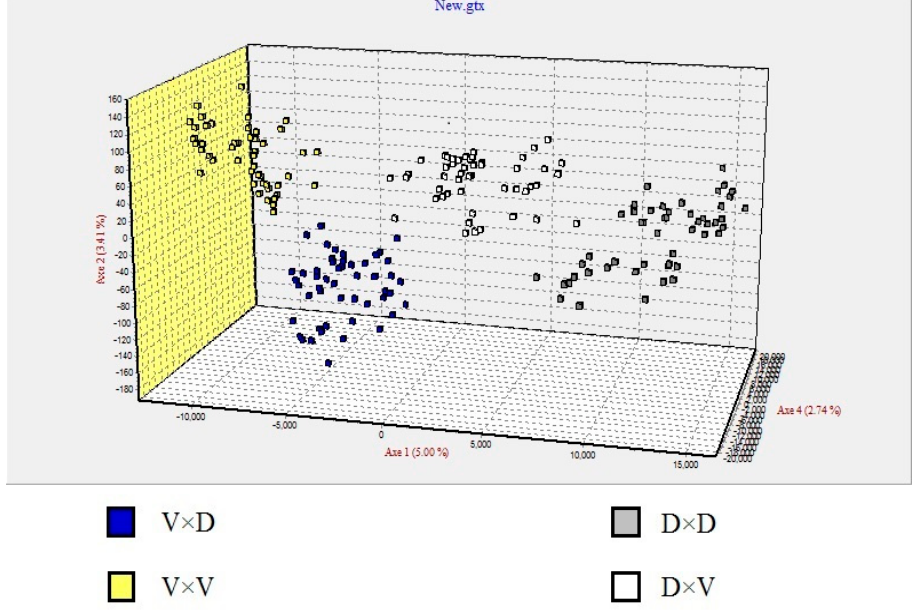
Figure 5. Factorial correspondence analysis based on six microsatellite loci illustrate the genetic relationships among the purebred and hybrid crosses. Volga sterlet purebred (yellow squares) ( n = 48), Danube sterlet purebred (grey squares) ( n = 48), Volga sterlet × Danube sterlet (blue squares) ( n = 48), and Danube sterlet × Volga sterlet (white squares) ( n = 48).